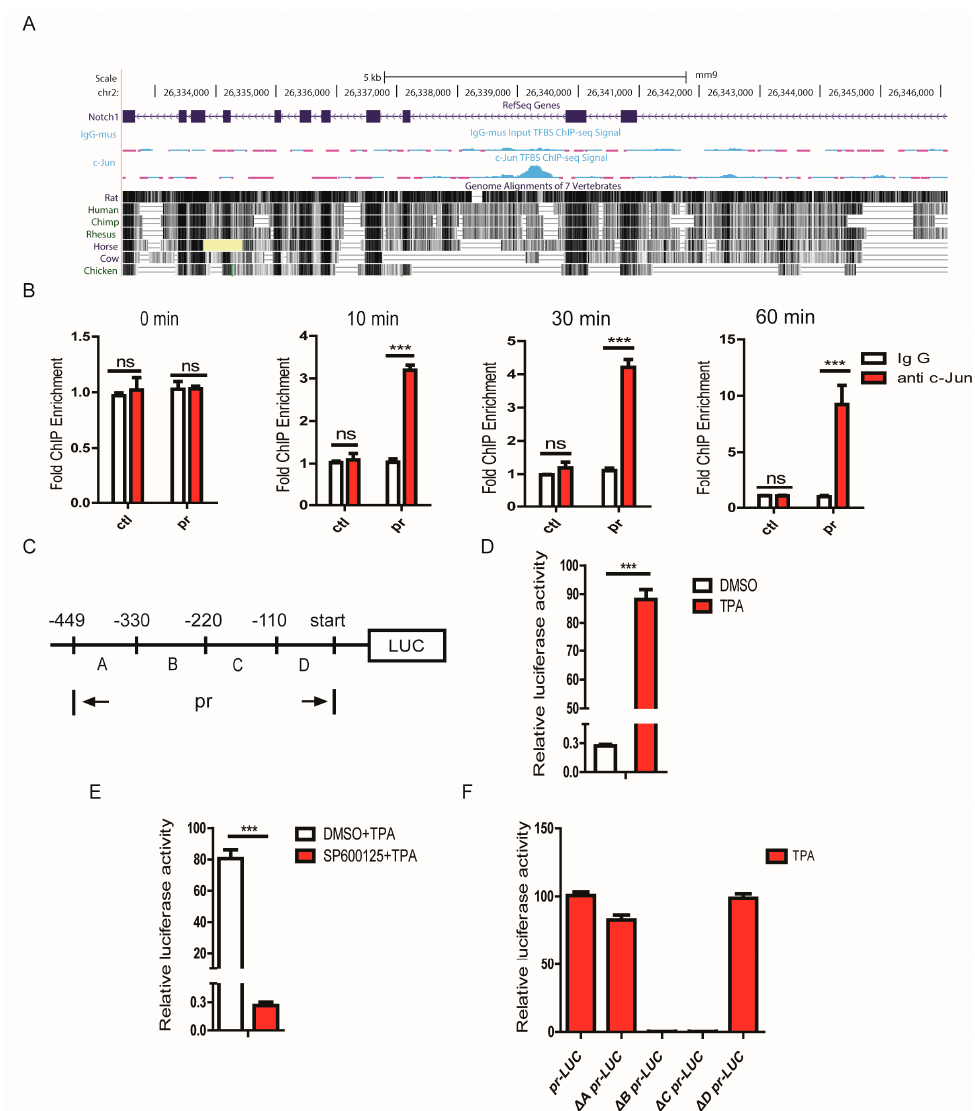
Figure 7. JNK1 regulated Notch1 transcription via activating c-Jun. ( A ) The chromatin immunoprecipitation (ChIP)-seq signal of c-Jun and corresponding control IgG in the region of Notch1. The four tracts show the Notch1 gene structure, IgG ChIP-seq signal, c-Jun ChIP-seq signal, and overall region sequence conservation of seven vertebrate species. ( B ) 661W cells were treated with light for the indicated times. Chromatin immunoprecipitation analysis of c-Jun DNA binding in the transcription regulatory region of Notch1. ( C ) A full-length pr was inserted into the luciferase reporter vector, pGL6-TA (The luciferase reporter vector contained minimal TA promoter). This is a schematic representation of the pr deletion constructs used in the following experiments. ( D ) Here, pr-Luc (Luciferase) reporter plasmids and pSV-RL (The luciferase reporter vector) Renilla internal control plasmids were transfected into HEK293 cells, and 48 h later, cells were treated with DMSO and 100 ng/mL of TPA for 30 min. Then, a luciferase assay was performed. ( E ) The pr-Luc reporter plasmids and pSV-RL Renilla internal control plasmids were transfected into HEK293 cells, and 48 h later, cells were treated with DMSO and 20 μ mol/mL SP600125 for 2 h and then treated with DMSO and 100 μ g/mL TPA for 30 min. ( F ) Here, pr-Luc or its truncation mutants were transfected into HEK293 cells, and 48 h later, cells were treated with 100 ng/mL TPA for 30 min. Then, a luciferase assay was performed. Graphs show the mean ± SEM, and the data (B,D,E,F) shown are representative of three independent experiments: ns, not significant; *** p < 0.001 (Wilcoxon–Mann–Whitney